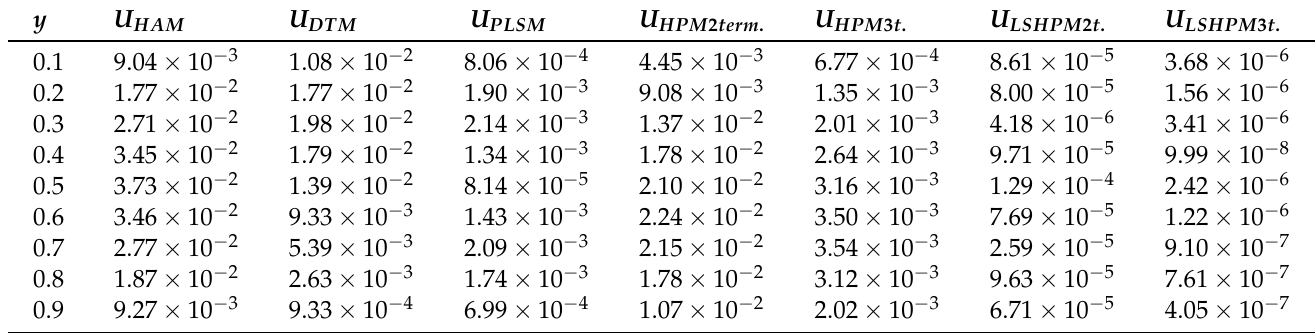
Table 1. Comparison of the absolute errors of the approximate solutions U in case Re = 1 and Ha = 0.